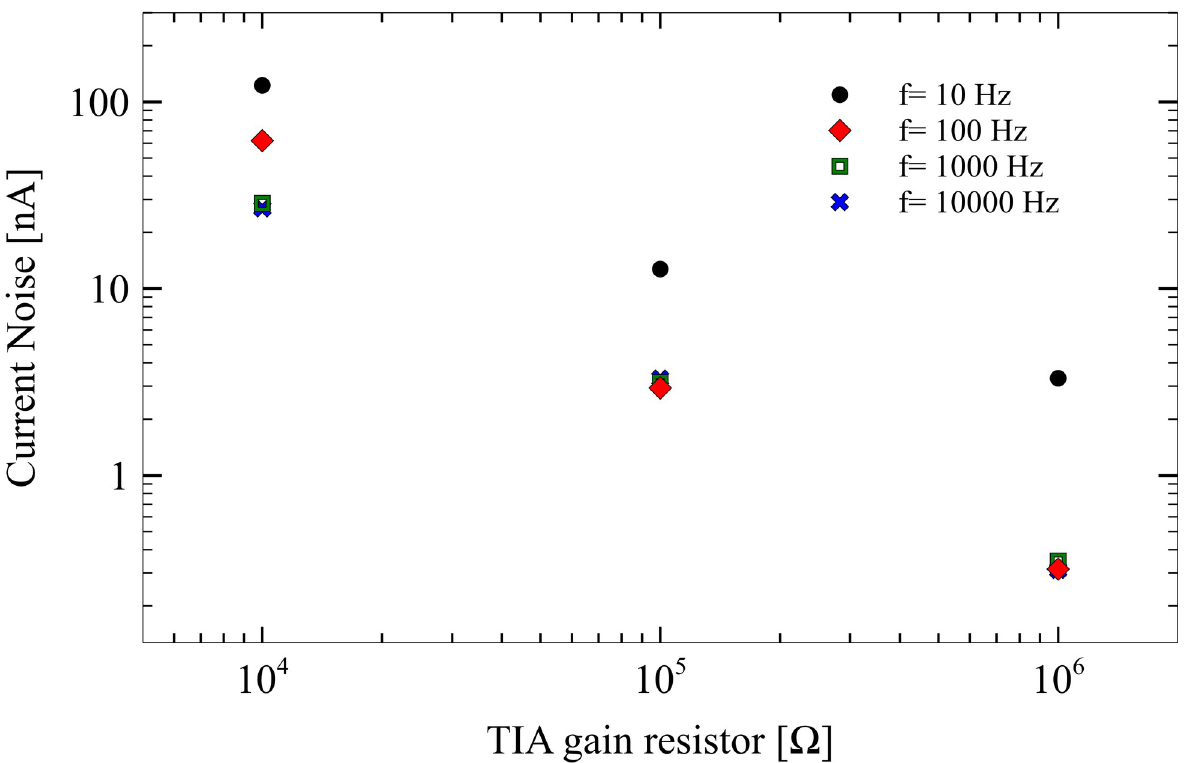
Fig 5. Current noise of TBISTAT for the 10–10000 Hz bandwidth and 10 K Ω -1M Ω TIA gain resistors.